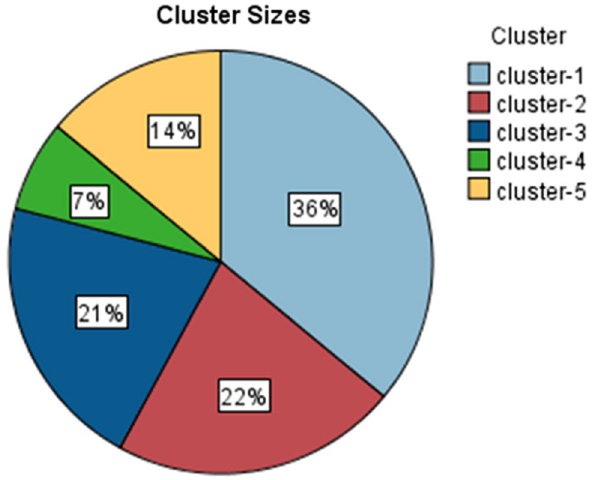
Fig. 6 The size of five clusters obtained from the K-means algorithm